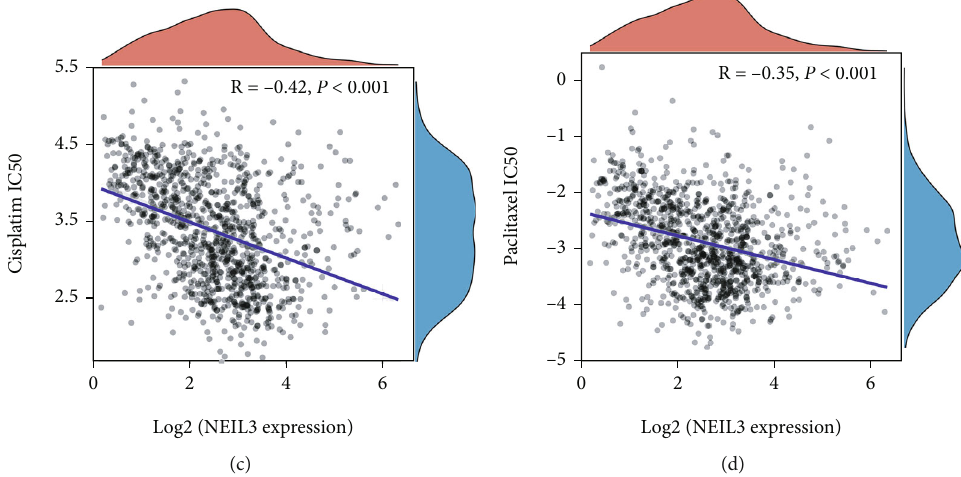
Figure 7: NEIL3 was associated with sensitivity to immunotherapy and chemotherapy in lung cancer patients. Notes: (a) correlation between NEIL3 and several immune checkpoint genes; (b) expression levels of NEIL3 in immunotherapeutic responsive and nonresponsive patients; (c, d) patients with higher NEIL3 might be more sensitive to cisplatin and